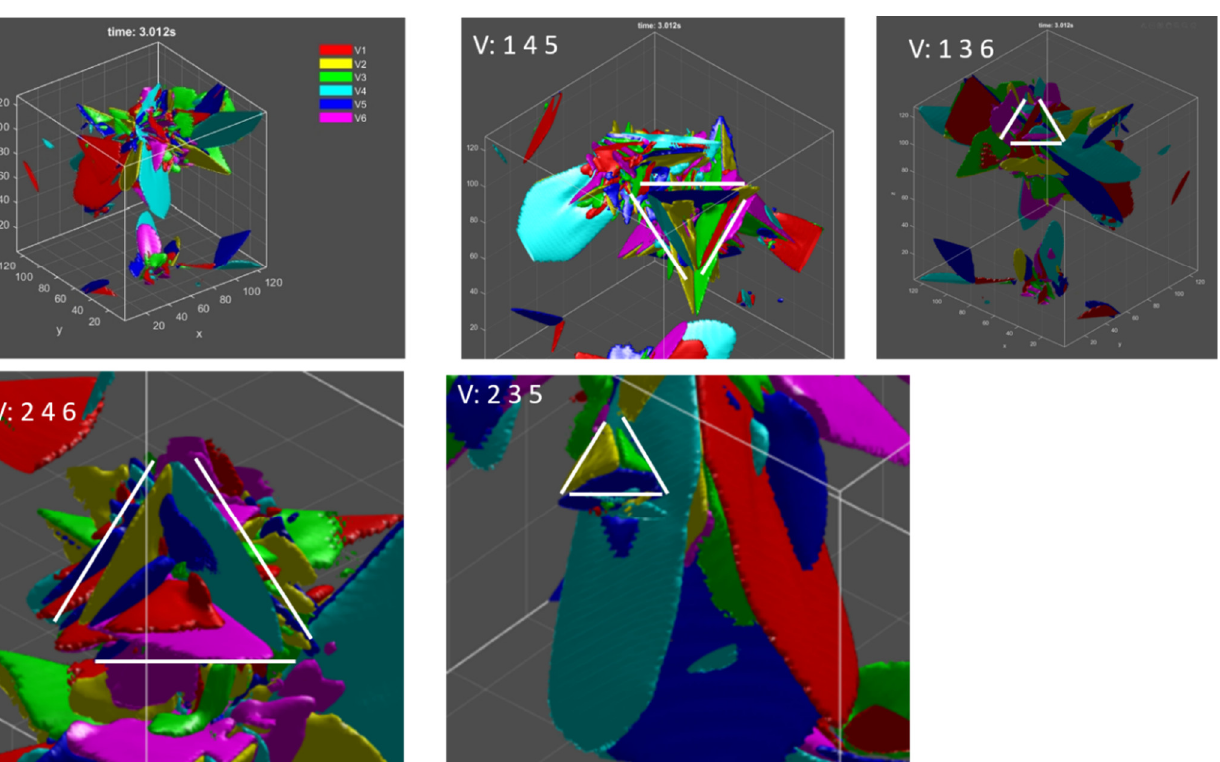
Figure 6. Triangular morphology with different variant combinations during martensitic transfor- mation by phase field modelling.